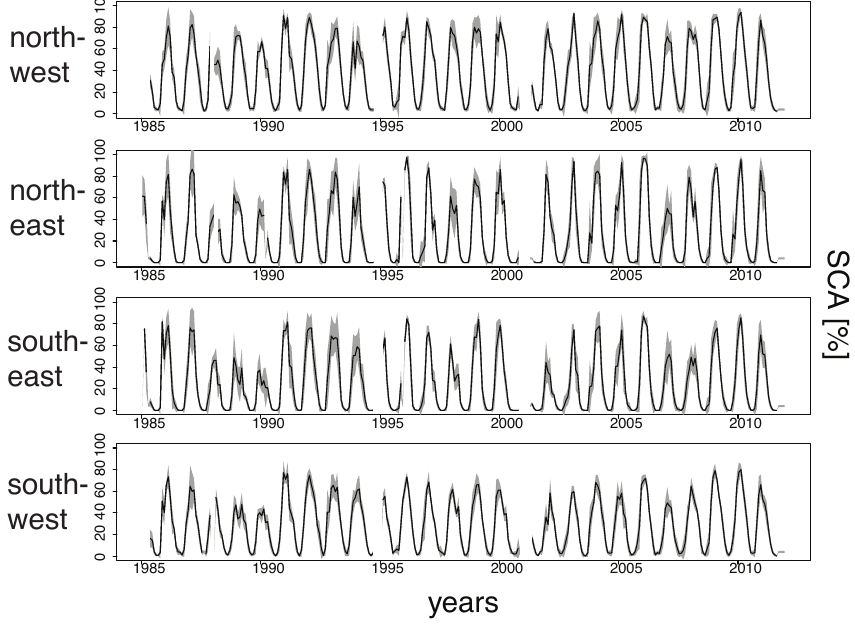
Fig. A1 Time series (1985–2011) of absolute monthly values of SCA for each region including monthly standard deviation (gray shaded area).